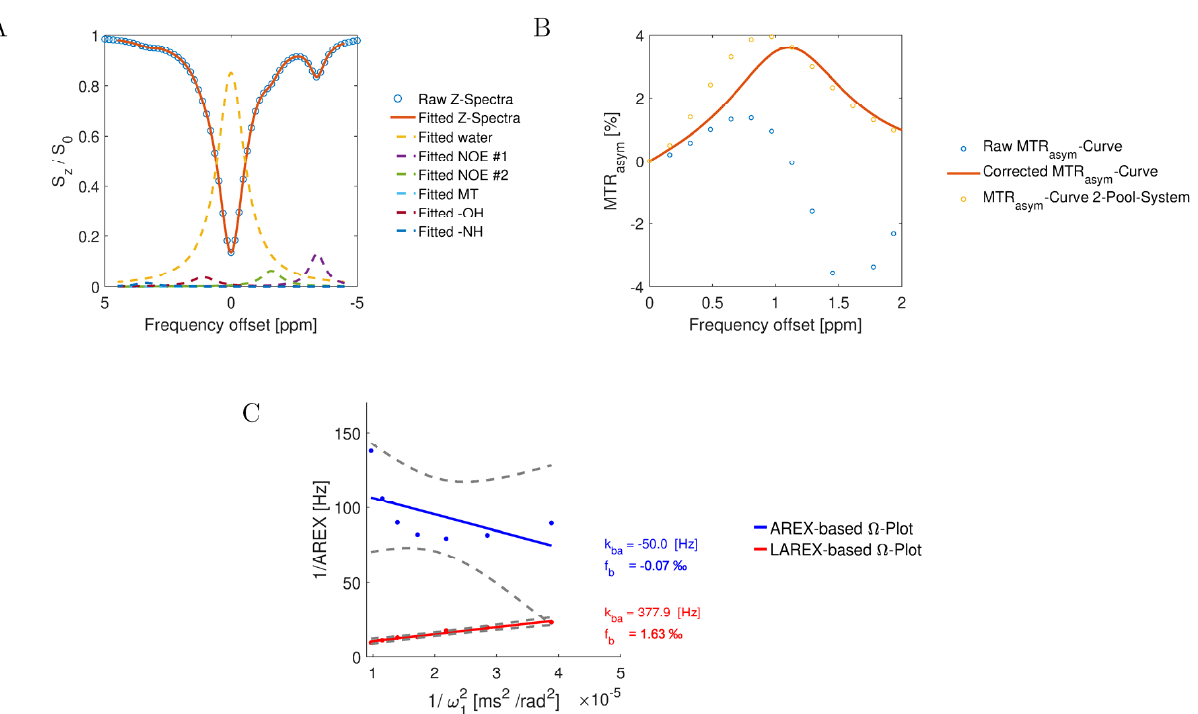
Figure 5. Graphical representation of an Ω -plot analysis using AREX and LAREX data, with Bloch–McConnell simulated Z-spectra for a 6-pool IVD exchange system. For the analysis, the parameters of the hydroxyl pool were f b = 1.8‰ and k ba = 400 Hz. The other pools’ parameters are outlined in Table 3. ( A ) Plot of an exemplary Z-spectra (blue circles) at B1 = 0.7 µ T and the fitted Z-spectra (red line), and the Lorentz fits of each pool (colored dashed lines). ( B ) The plot of the MTR asym curve for the simulated raw Z-spectra (blue circles, Raw MTR asym -Curve), the MTR asym - Curves based on the Lorentz corrected Z-spectra to a two-pool system of water and Gag-OH (red line, Corrected MTR asym -Curve), and the ground truth MTR asym -Curve with based on a Bloch–McConnell simulation with only 2-pools (yellow circles, MTRasym -Curve 2-Pool-System). ( C ) Visualization of the AREX (blue line) or LAREX-based (red line) Ω -plots. The gray dashed lines illustrate the 95% confidence interval of the linear omega